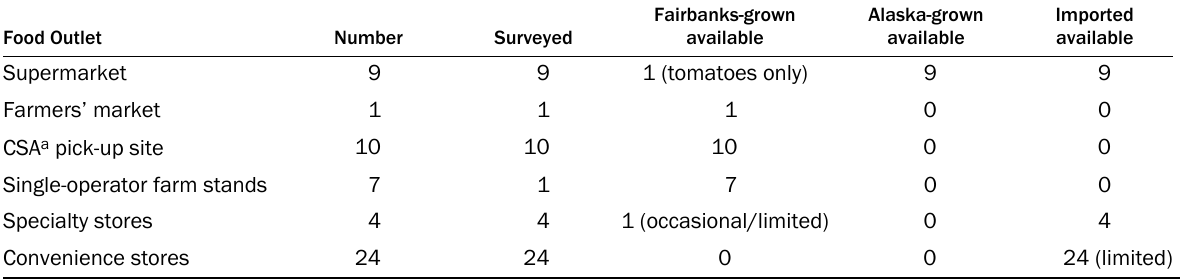
Table 1. Fairbanks Food Outlets Included in Local Food Access